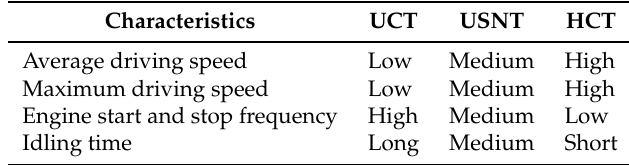
Table 1. Characteristics of three defined traffic-condition types. Note: UCT, Urban Congestion Type; USNT, Urban/Suburb Normal Type; HCT, Highway Clear Type.